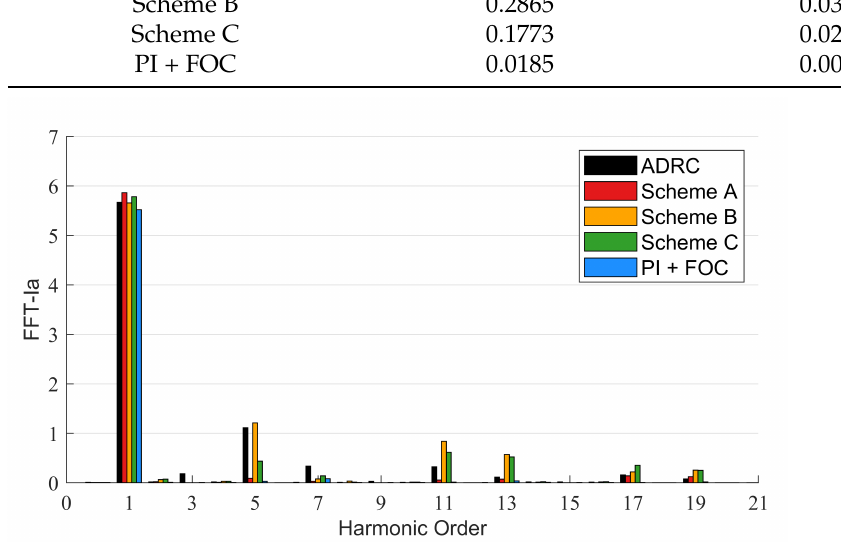
Figure 13. FFT of motor phase current.